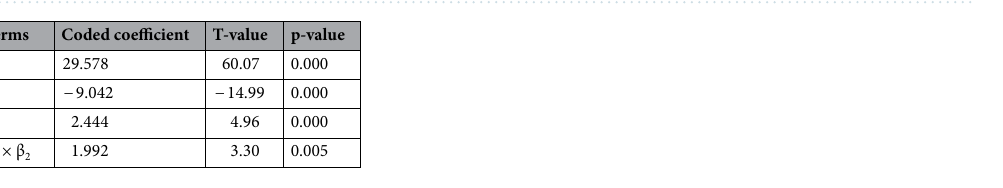
Table 3. Estimated regression coefficients, T- and